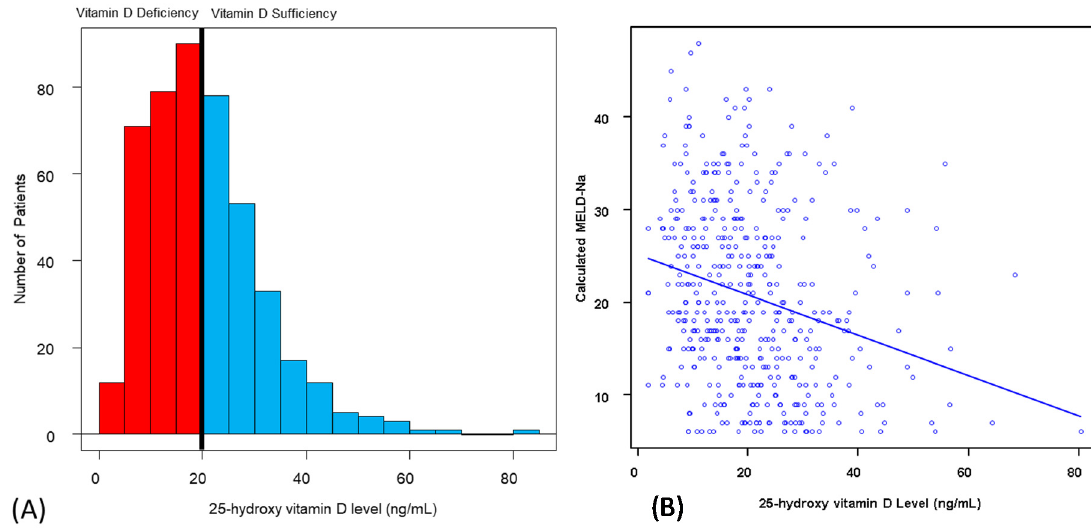
Figure 1. 25-hydroxy vitamin D levels in patients prior to LT. ( A ) Distribution of the 25-hydroxy vitamin D levels in the pre-transplant period. ( B ) Correlation between the 25-hydroxy vitamin D levels and MELD-Na score. Correlation coefficient r was − 0.254 ( p < 0.01; 95% CI: − 0.34– − 0.17). CI: confidence interval; MELD-Na: the model for end-stage liver disease. LT: liver transplantation.